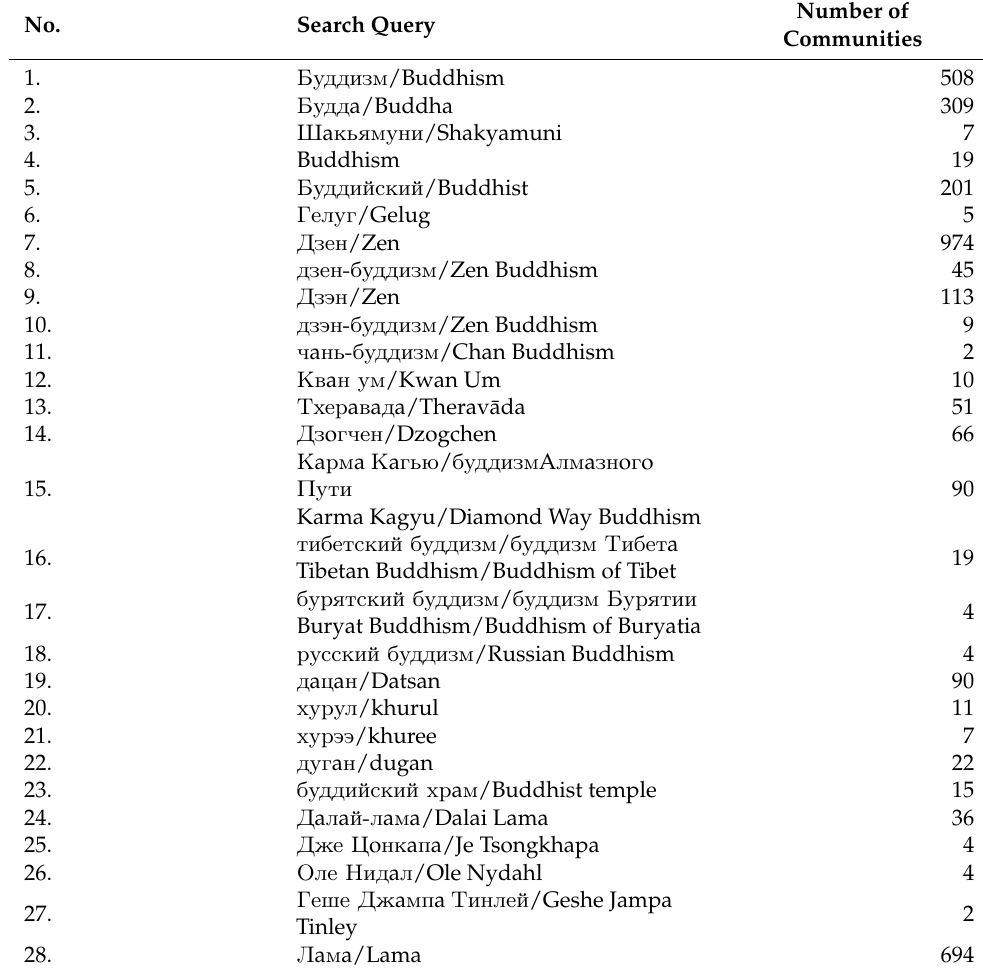
Table 1. Number of communities by units of